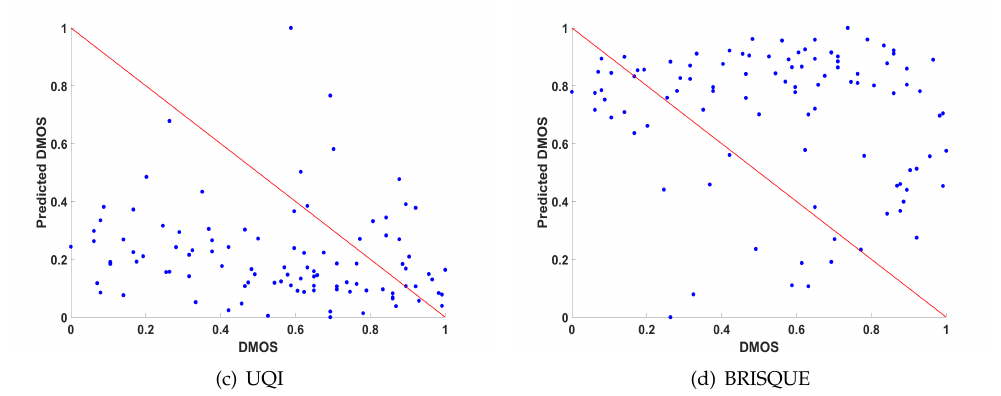
Figure 18. Scatter plots of linear performance of the best two metrics ( a ) NQM, and ( b ) RFSIM and the two worst assessments ( c ) UQI, and ( d )